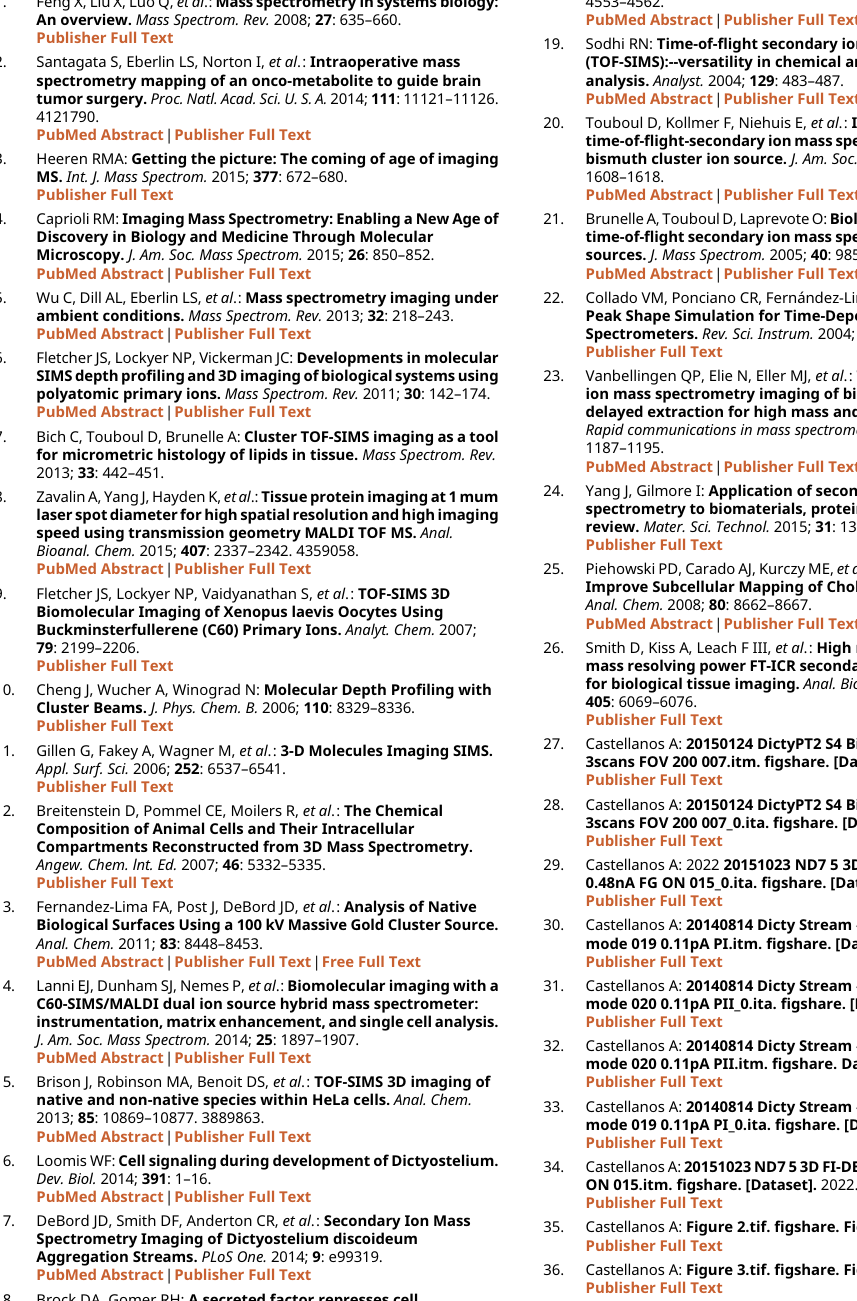
35. Castellanos A: Figure 2.tif. figshare. Figure. 2022. Publisher Full Text 36. Castellanos A: Figure 3.tif. figshare. Figure. 2022. Publisher Full Text 37. Castellanos A: Figure 1.tif. figshare. Figure. 2022. Publisher Full